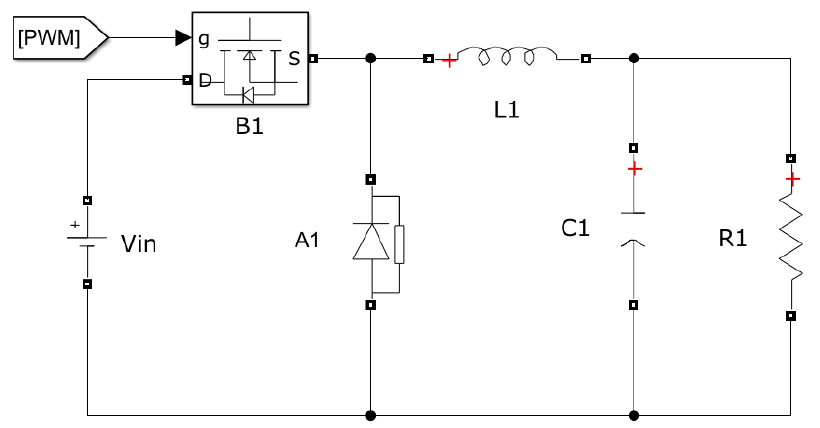
Figure 3. Simulink/Simscape model of the buck converter.